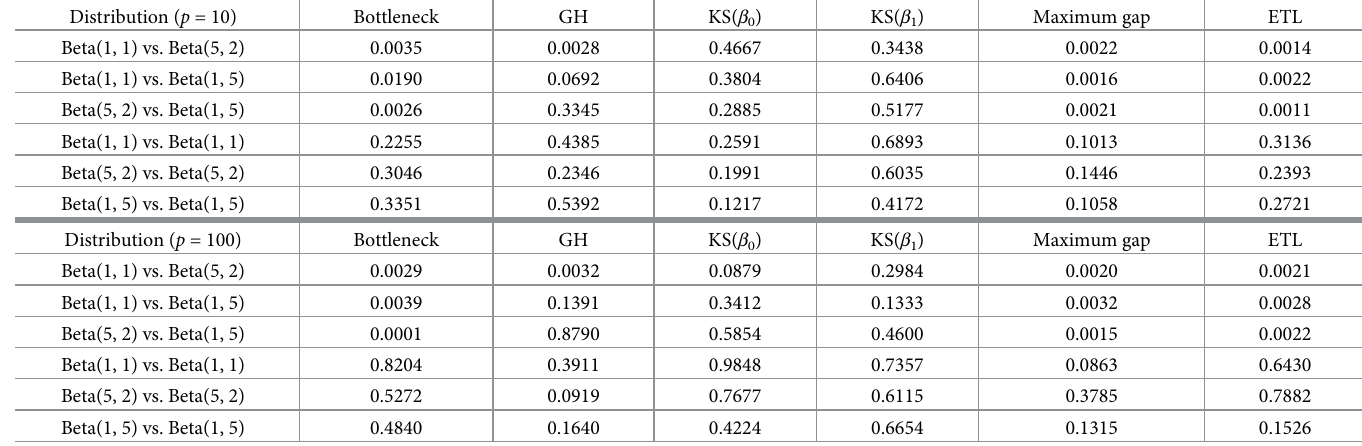
Table 2. The average p -values obtained using bottleneck, GH, KS, maximum gap, and ETL based statistics for small ( p = 10) and large ( p = 100) network settings. There were 6 networks in each group. The p -values smaller than 0.01 indicate that the corresponding method can identify network differences at a 99% confidence level.